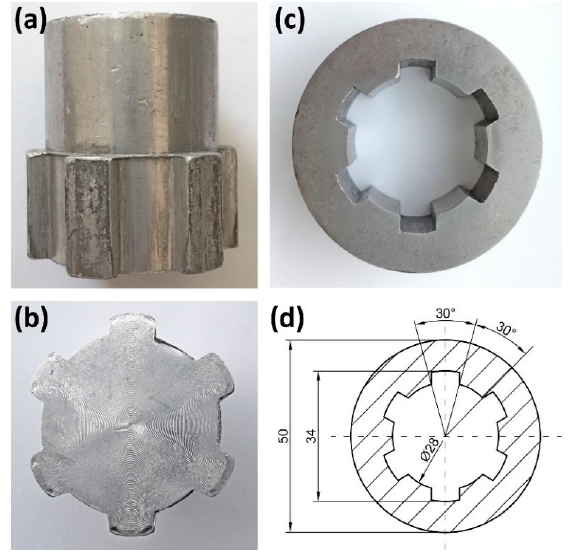
Figure 3. Extruded gear-like element ( a , b ) and corresponding die insert ( c , d ).